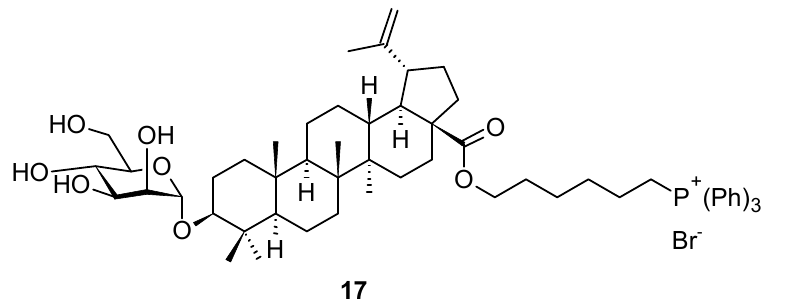
Figure 17. Lupane-type triterpenoid saponin derivative.